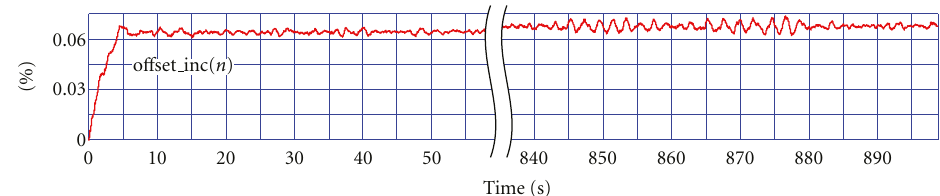
Figure 9: Estimated rate of timing drift for room recording with ambient noise but no target signal.